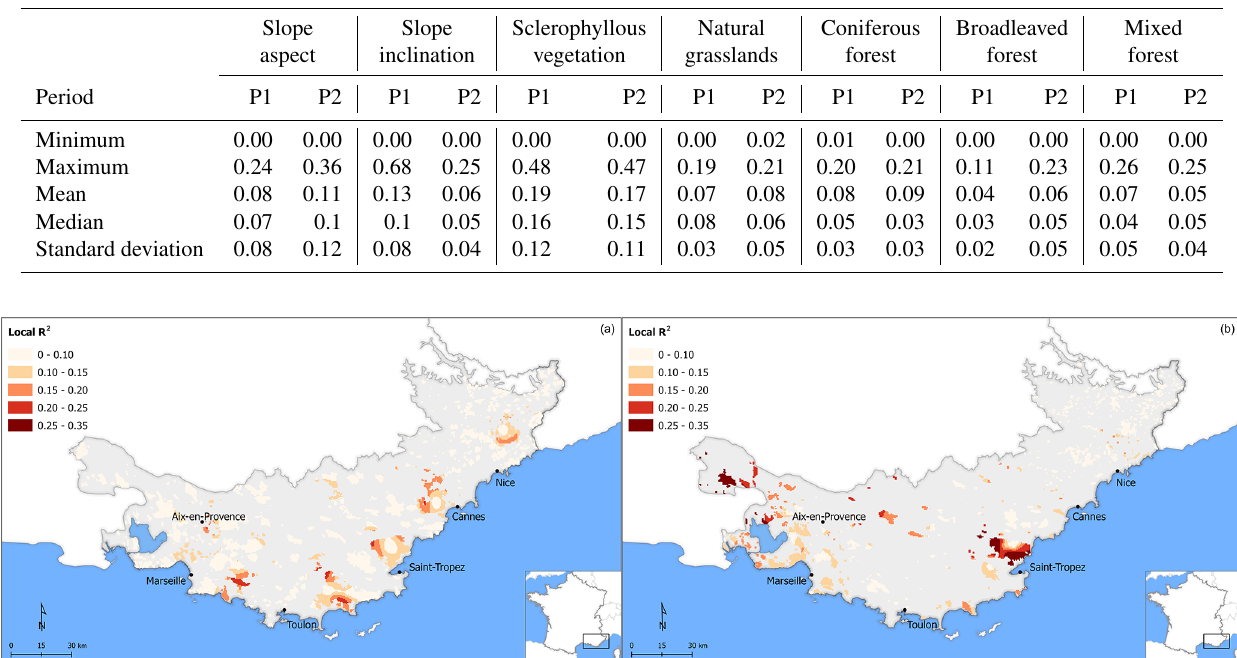
Table 4. Descriptive statistics of local R 2 per environmental factor for 1970–1994 (P1) and for 1995–2019 (P2).